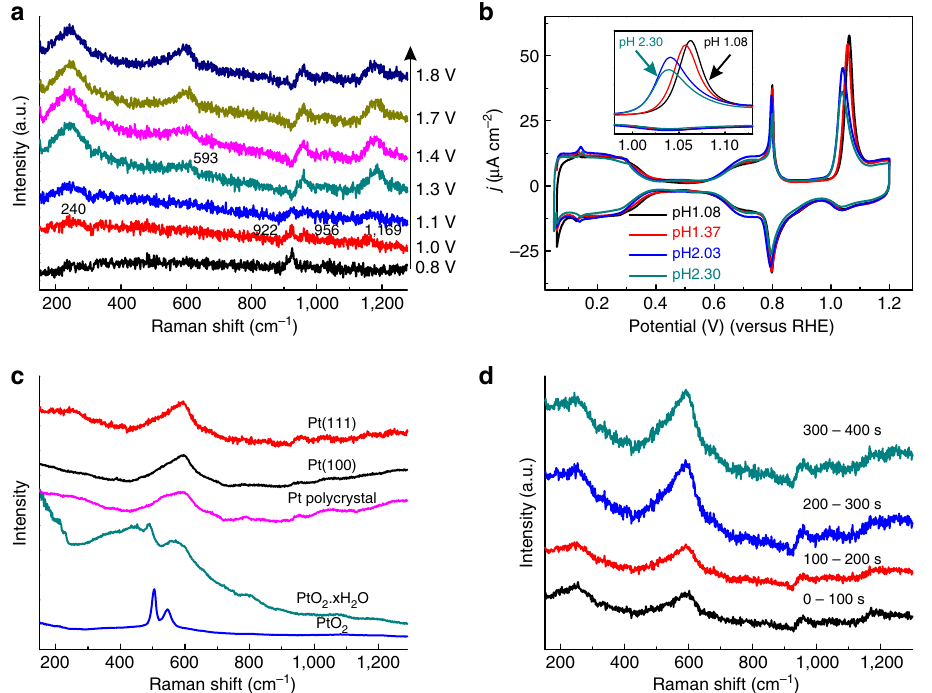
Figure 3 | Raman spectra of (su-)peroxide and oxide formation. ( a ) Potential dependent Raman spectra of Pt(111) in 0.1M HClO 4 electrolyte; ( b ) pH-dependent cyclic voltammograms of Pt(111) in HClO 4 /NaClO 4 electrolyte with a constant concentration of 0.1M ClO 4 (cid:2) with a scan rate of 50mVs (cid:2) 1 ; ( c ) Raman spectra of Pt(111), Pt(100) and polycrystalline Pt at 2.0V, and normal Raman spectra of amorphous PtO 2 (cid:3) xH 2 O and a -PtO 2 ; ( d ) oxidation time-dependent Raman spectra of Pt(111) at